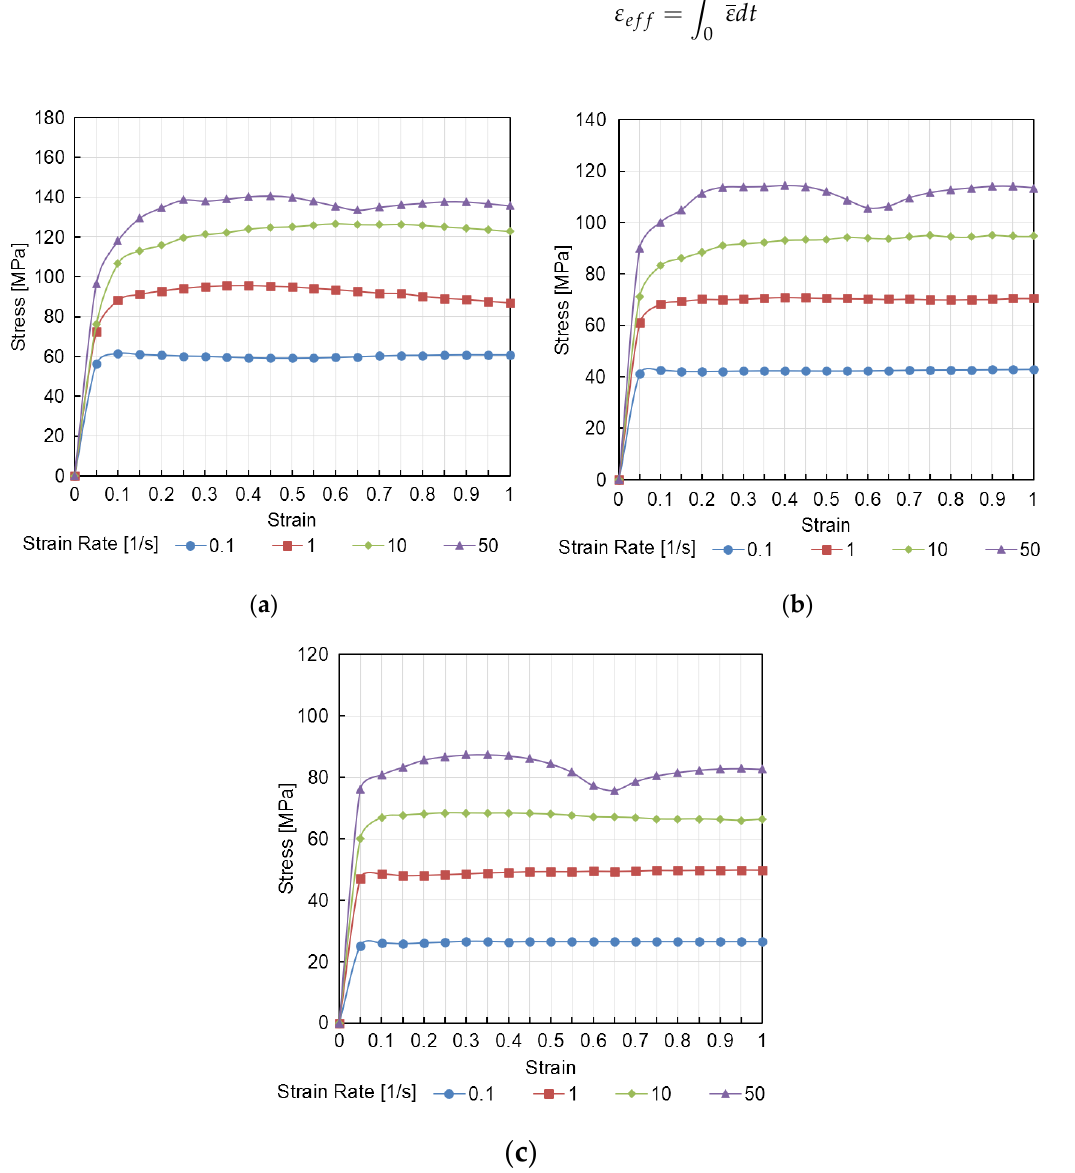
Figure 3. Plastic flow curves for the ZCF aluminum alloy for temperatures of ( a ) 400 °C, ( b ) 450 °C, and ( c ) 500 °C